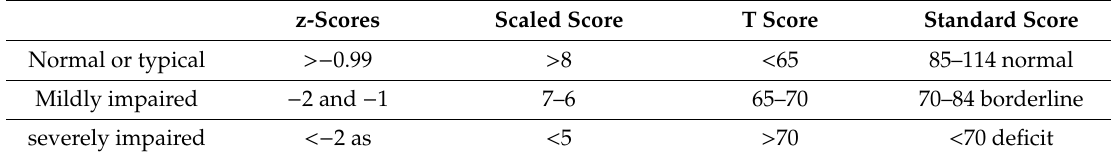
Table 2. Results interpretation according to standardized scores. Scaled